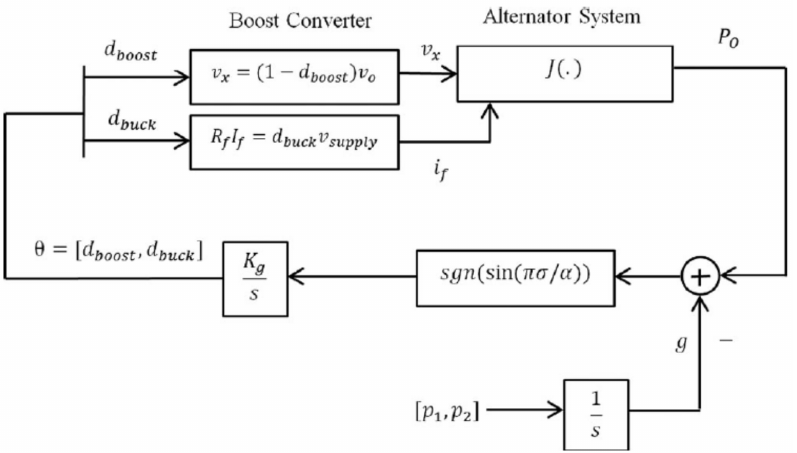
Figure 29. Block diagram for the proposed control circuit “Adapted with permission from [28]”.